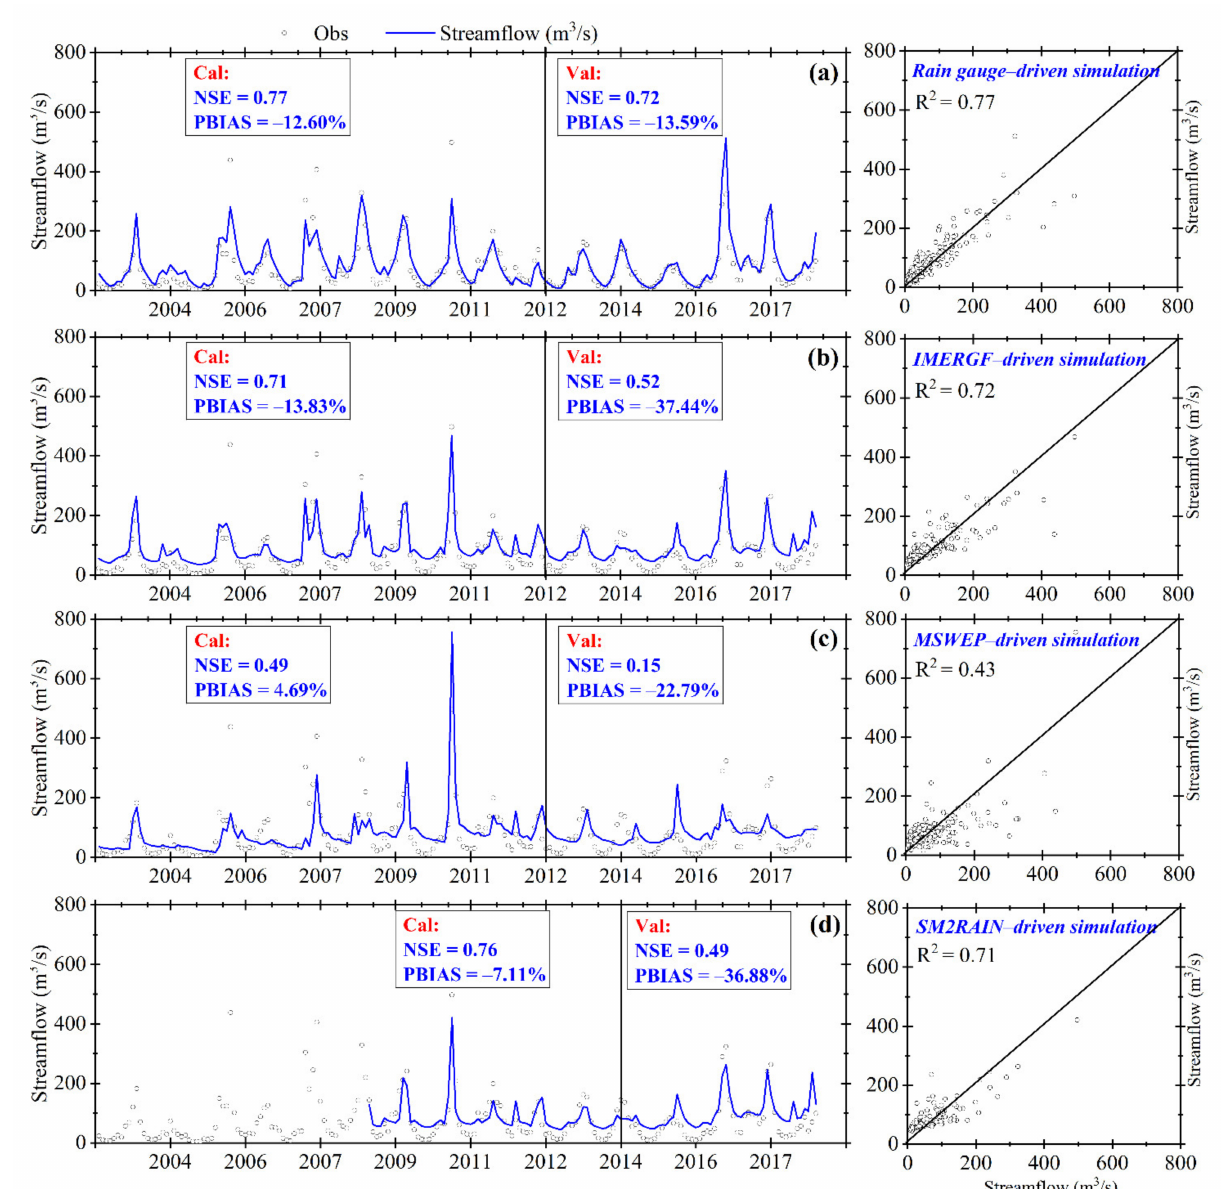
Figure 11. Same as Figure 7 but for monthly simulation, performed by ( a ) rain gauge, ( b ) IMERGF- V6, ( c ) MSWEP, and ( d ) SM2RAIN–ASCAT, at the SRB, during 2003–2018. The calibration period is 2003–2011 from ( a – c ) and 2009–2013 for ( d ); the validation period is 2012–2018 from ( a – c ) and 2014–2018 for ( d